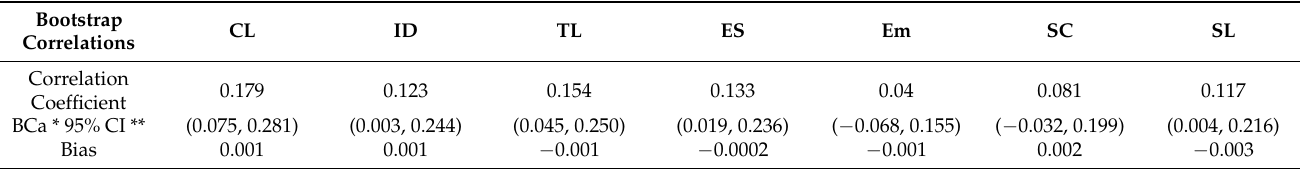
Table 7. The impact of Professional Experience on Organizational Learning subscales (Bootstrap 1000 samples). Bootstrap Correlations